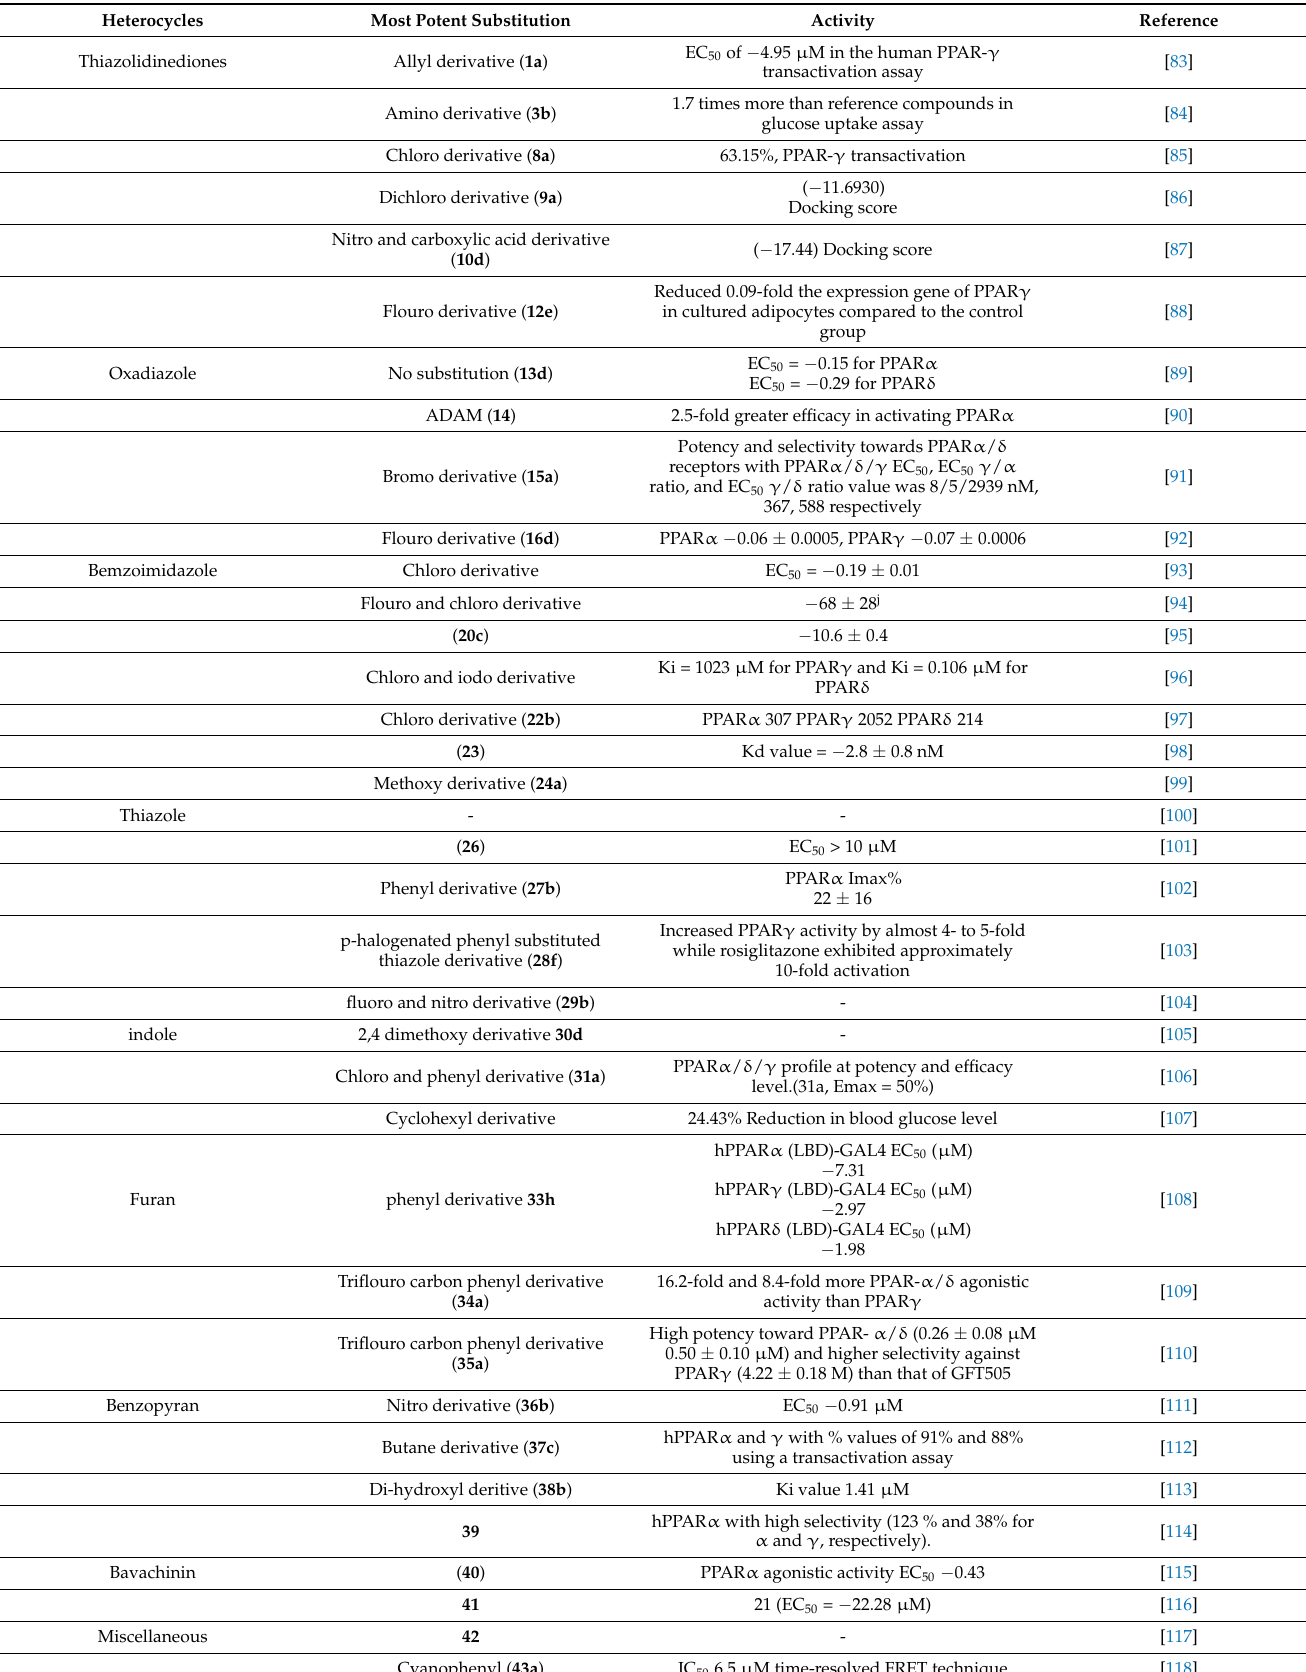
Table 2. Summary of various heterocycles with the different substitutions for Peroxisome proliferator- activated